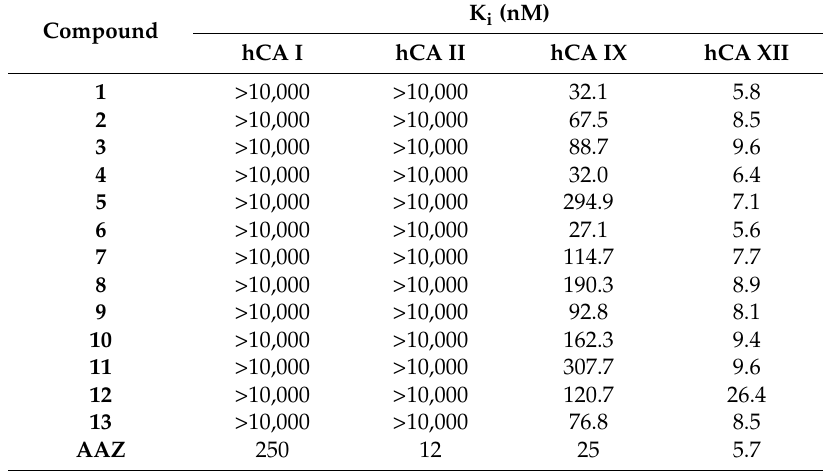
Table 1. Inhibition data of h CA I, h CA II, h CA IX, h CA XII with compounds here reported and